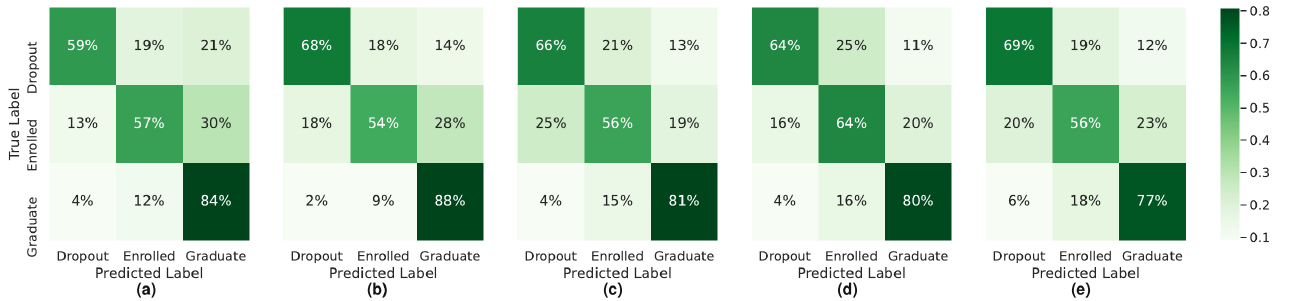
Figure 2. Confusion Matrices for the models built with dataset S0: ( a ) SMOTE + RF, ( b ) SVMSMOTE + RF, ( c ) BRF, ( d ) EE, and ( e ) RB.